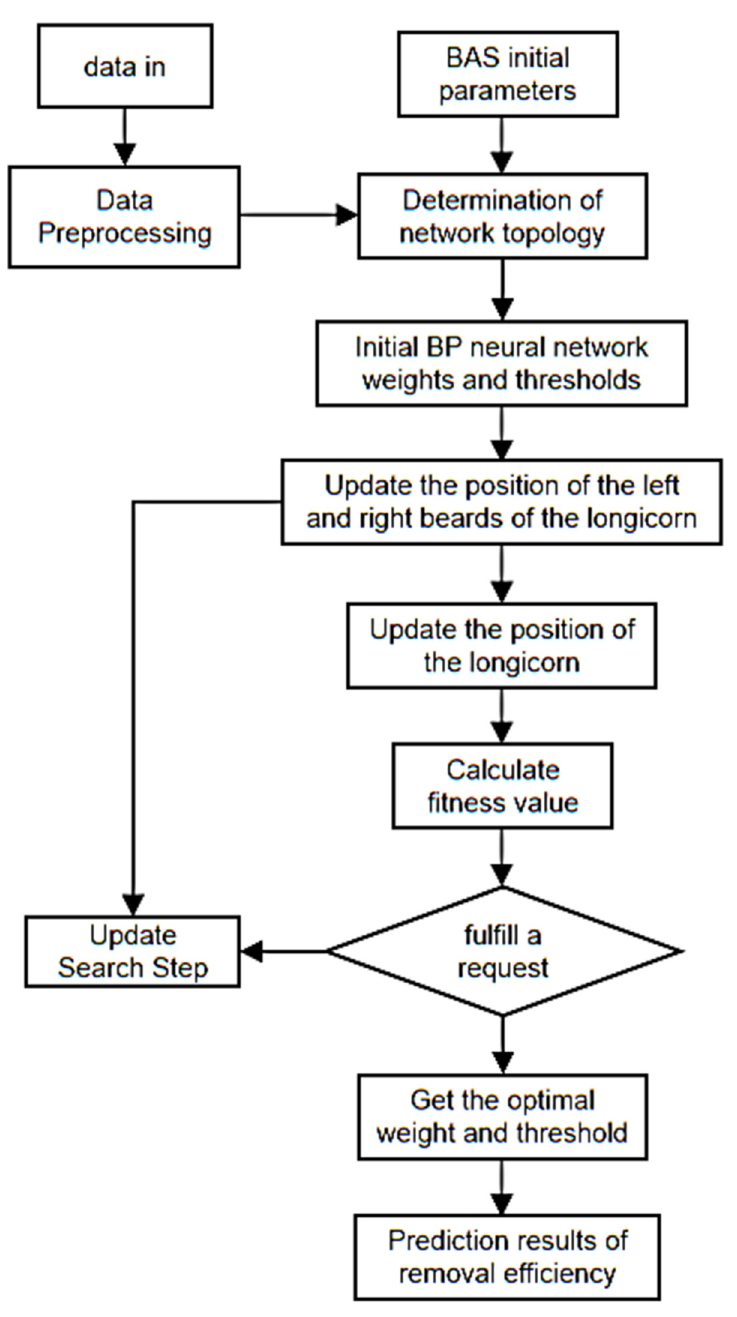
Figure 15. BAS optimization process of BP neural network.